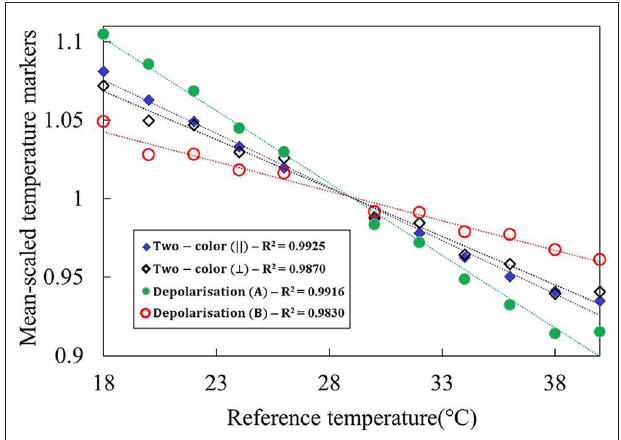
FIGURE 5 | Mean-scaled temperature markers for Milli-Q